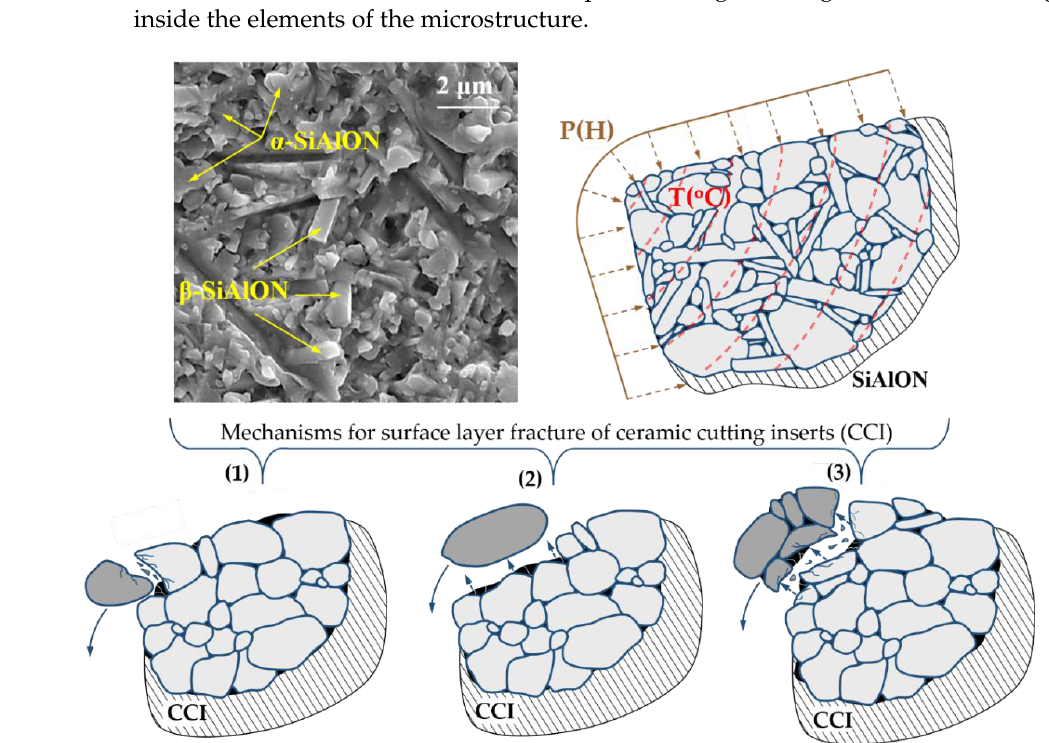
Figure 1. Variants of the destruction of the surface layer of SiAlON tool ceramics under external mechanical (P) and thermal (T) loads: intragranular (1), grain-boundary (2), and mixed